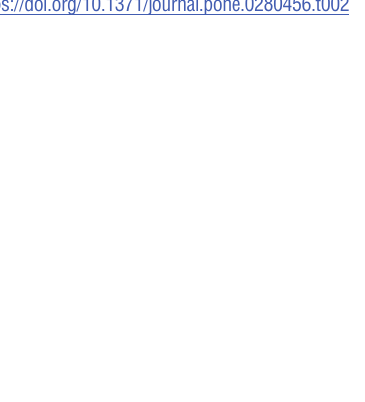
The values in bold indicate significant differences.